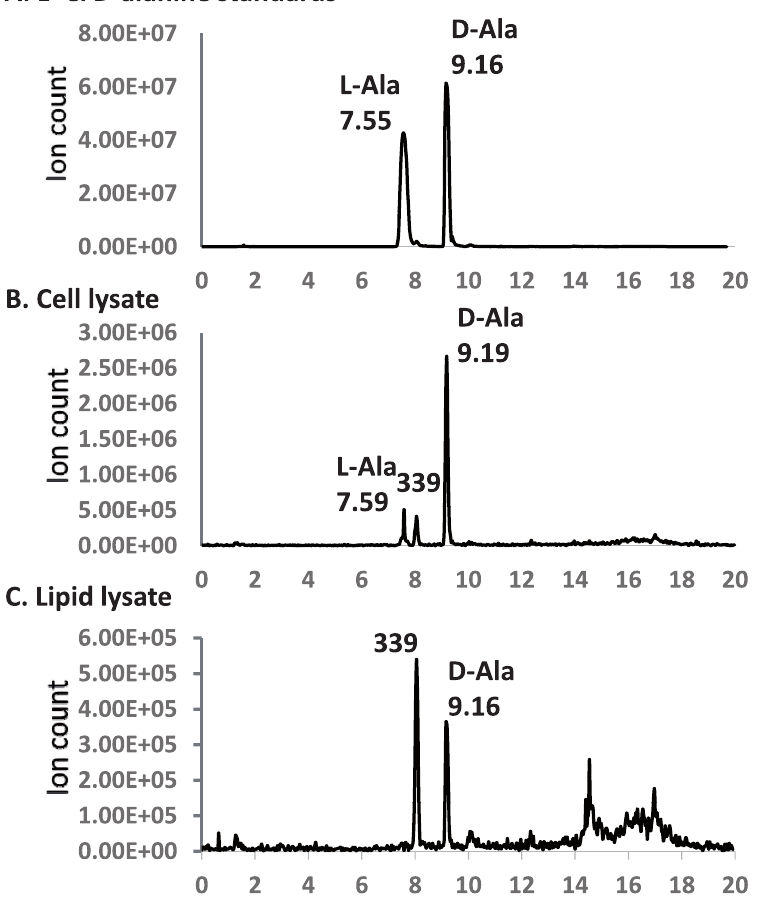
Figure 8. LC/MS chromatograms of alanine in cell and lipid lysates. The 340 amu molecular anion was monitored. The horizontal axis corresponds to retention time (minute). Peak retention times are marked. The peaks at 8.05 minutes, which correspond to a background 339 amu anion, is marked with